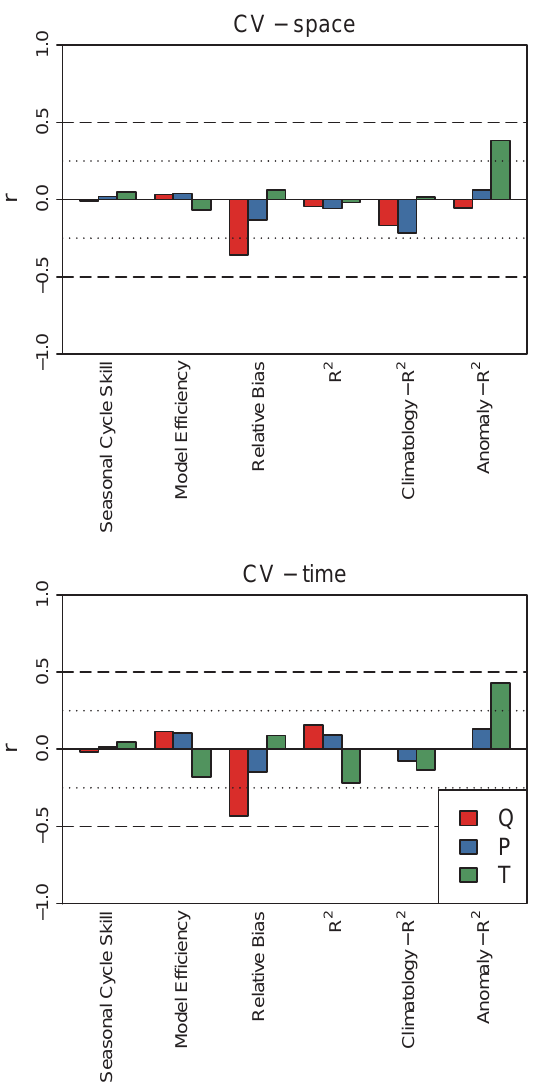
Figure 8. Dependence of model skill on climatic conditions: cor- relation between grid-cell-level performance of the random forest model with full atmospheric forcing and mean climatic conditions ( Q : mean annual runoff; P : mean annual precipitation; T : mean an- nual temperature). Horizontal lines at r = ± 0 . 25 and r = ± 0 . 5 are included as a visualisation aid. Spatial patterns of the performance metrics are shown in Figs. 6 and 7.